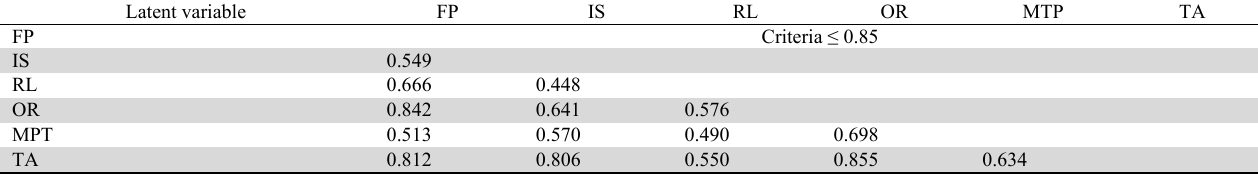
Discriminant validity (Heterotrait-Monotrait ratio of correlations) Latent